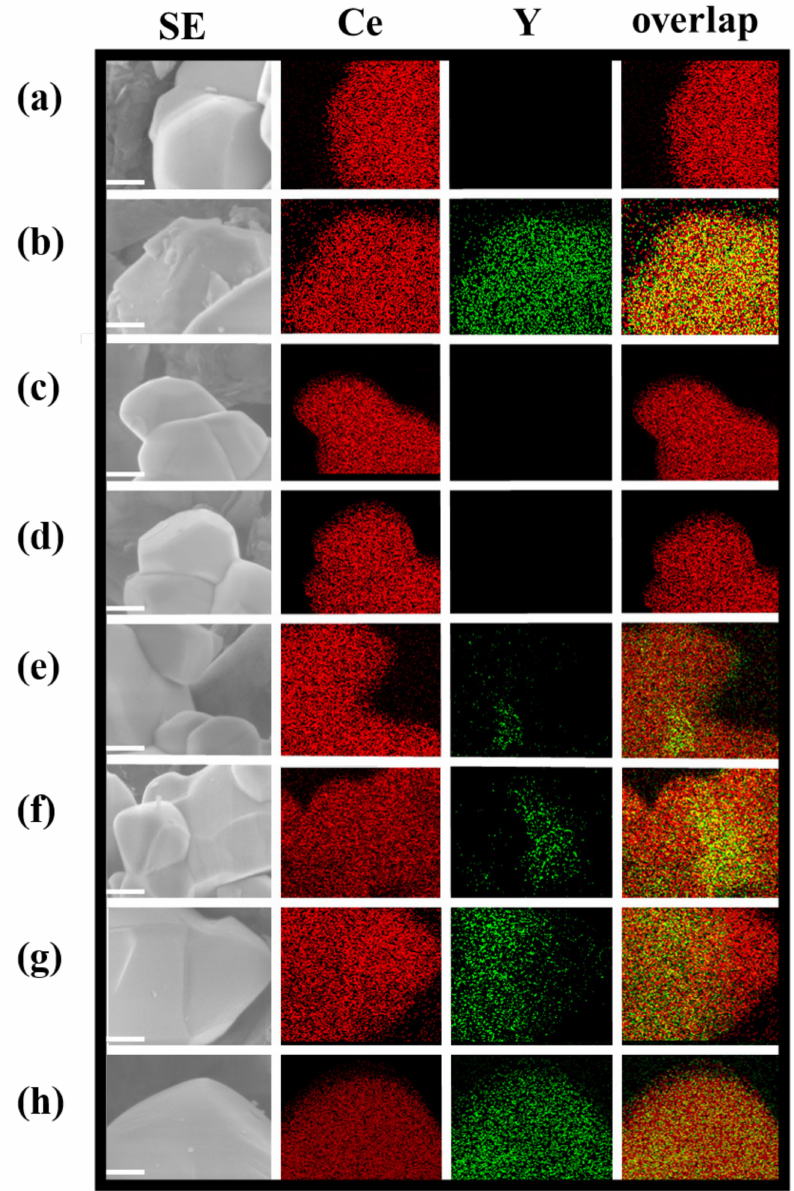
Figure 2. FE-SEM/EDS images of 1573K-Pure-CeO 2 ( a ), 1573K-CPT ( b ), 1273K-SSR ( c ), 1373K-SSR ( d ), 1473K-SSR ( e ), 1573K-SSR ( f ), 1673K-SSR ( g ), and 1773K-SSR ( h ). Scale bars are 100